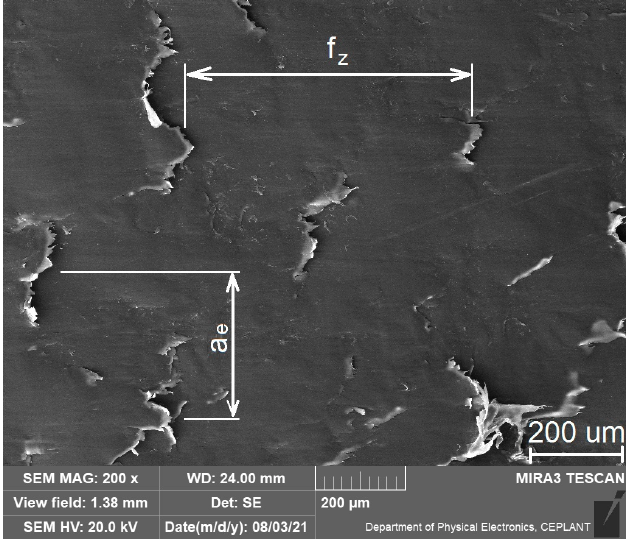
Figure 15. A distribution of the surface asperities corresponding with the cutting conditions—feed per teeth f z and radial stepover a e .